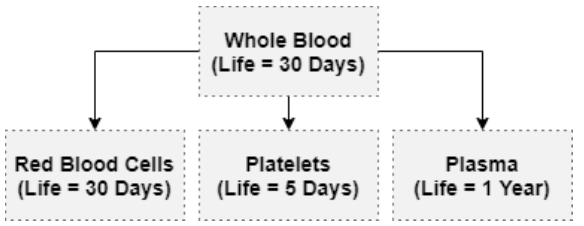
Figure 2. Componentizing of whole